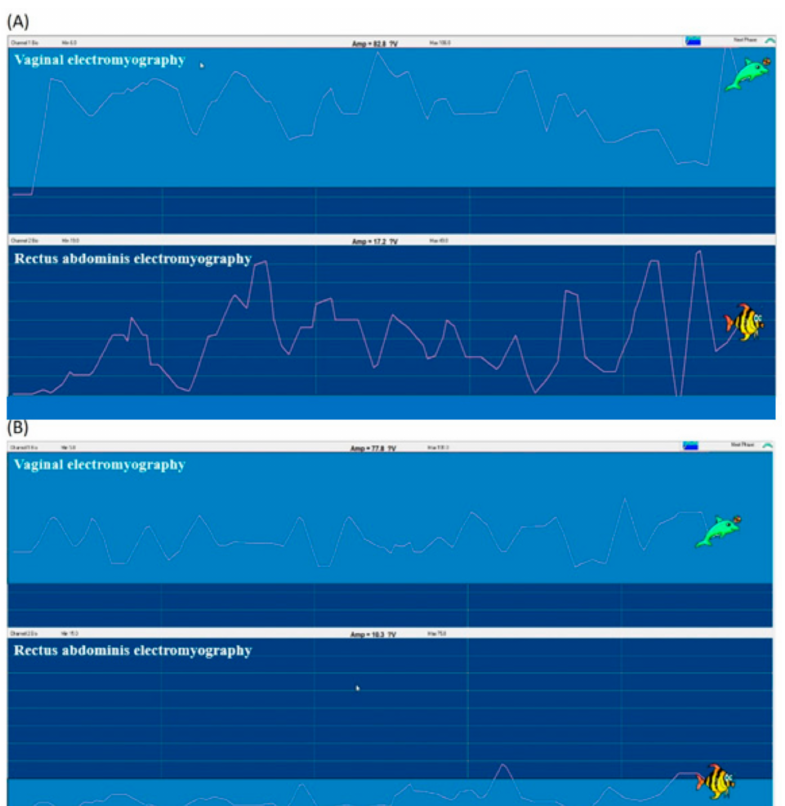
Figure 4. Vaginal electromyography and rectus abdominis electromyography examinations ( A ) before, and ( B ) after the rehabilitation program. ( A ) The rectus abdominis was inadequately in- duced for compensatory contraction. ( B ) After training, PFM contraction (measured with vaginal electromyography) was improved while the compensatory contraction of the rectus abdominis was remarkably reduced.